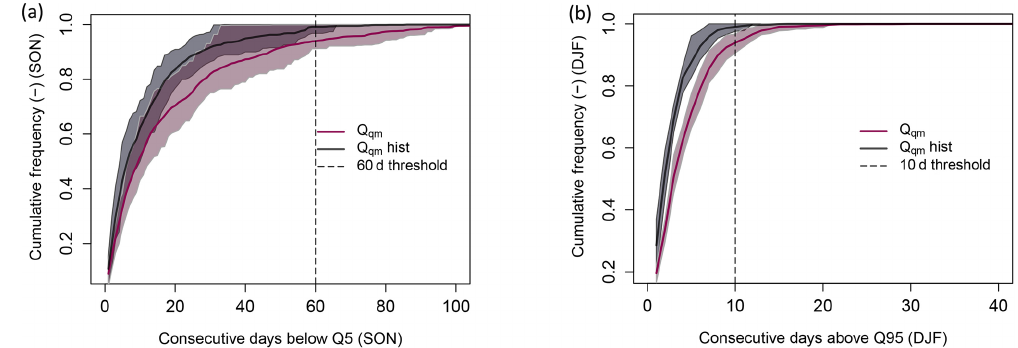
Figure 6. Cumulative distribution functions (CDFs) are shown, where the historical period (1980–2009; gray) is compared to the future period (2070–2099; purple) for the Vernex catchment. (a) CDFs for consecutive days below Q5 are shown for the SON season, and a 60d threshold is indicated by the black dashed line. (b) CDFs of the consecutive days above Q95 are shown for the season of DJF, and a 10d threshold is shown by the black dashed line. Instances where the simulations exceed their associated threshold represent a level of change that is of interest to Groupe E. The mean (solid lines) and likely range (shaded areas) are shown, where the likely range represents two-thirds of the